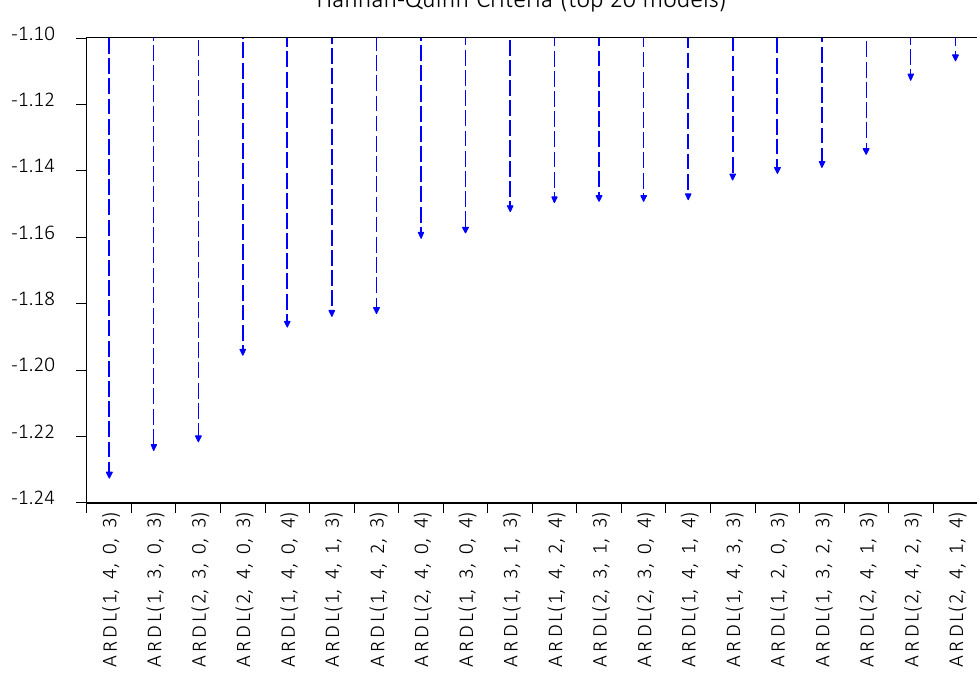
Figure 10. Selection of the optimal model ARDL according to Hanna-Quinn criterion